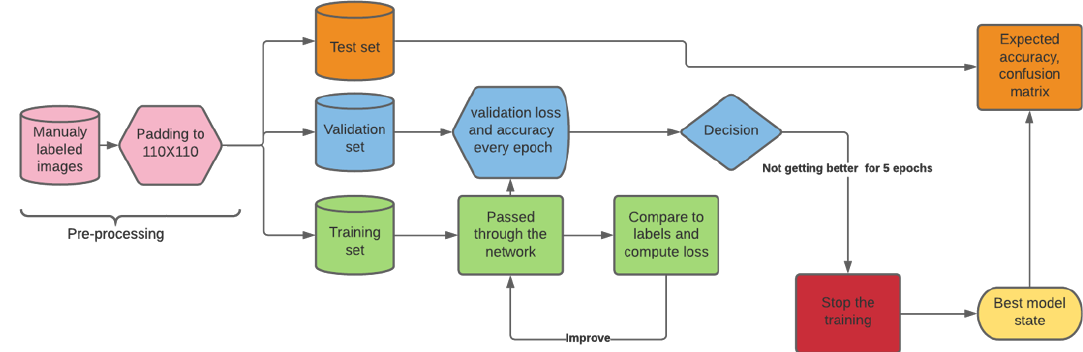
Figure 3. Overview of training methodology.